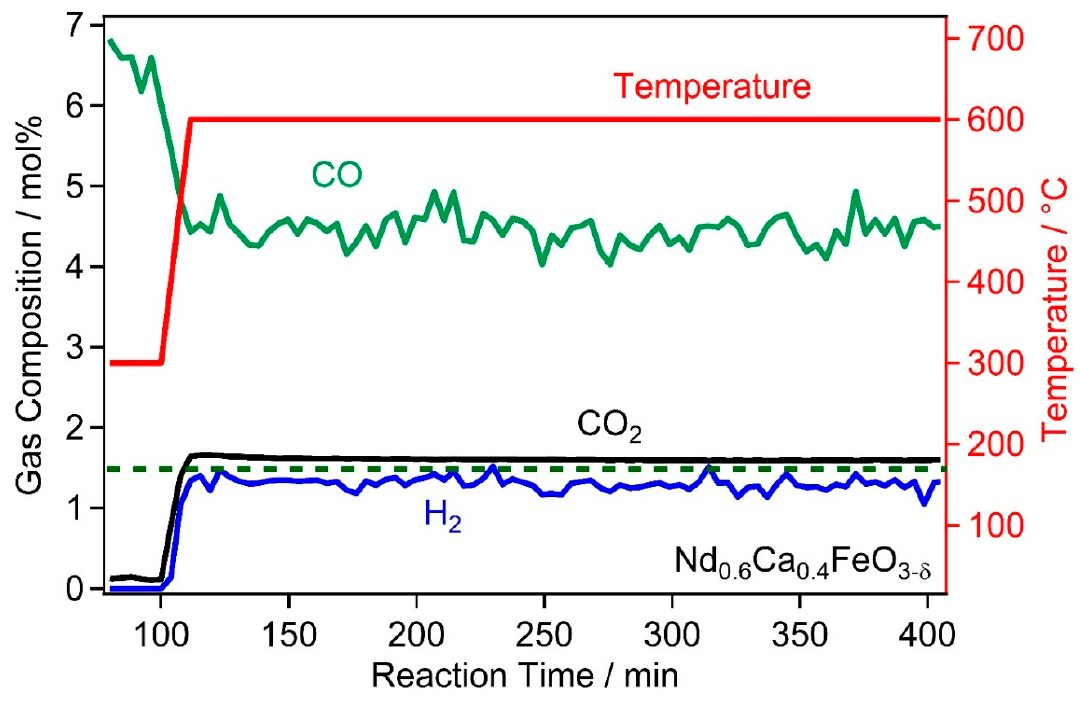
Figure 6. Isothermal HT-WGS reaction at 600 °C for Nd 0.6 Ca 0.4 FeO 3- δ . The dashed line serves as a horizontal guide for the eye. During the duration of the reaction (about 5 h), the catalyst exhibited stable reactivity.